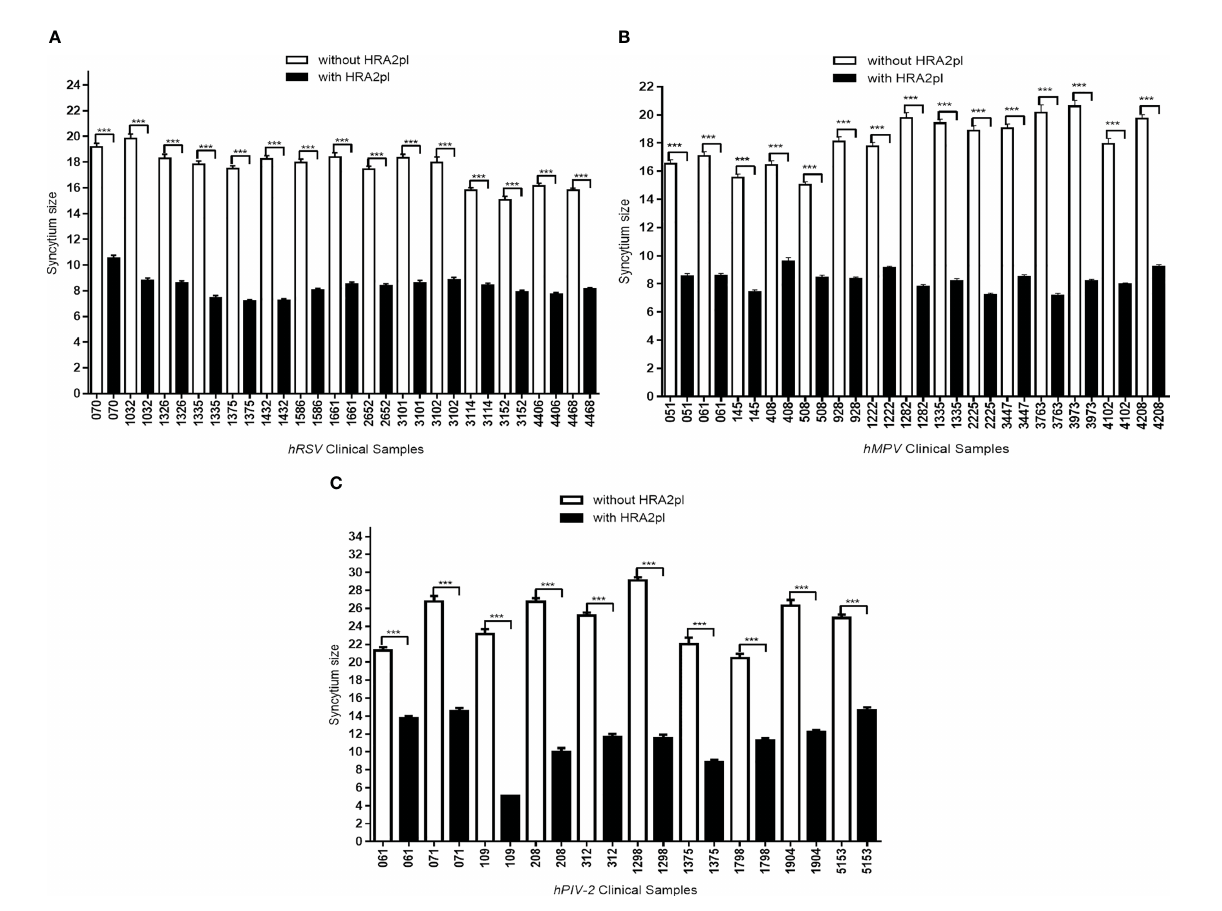
FIGURE 3 The syncytium size was reduced after treatment with HRA2pl B2. In HEp-2 cultures infected with (A) hRSV or (B) hMPV viral isolates, and (C) in Vero cultures infected with hPIV-2 viral isolates, treatment with HRA2pl signi fi cantly reduced the syncytium size. *** p <